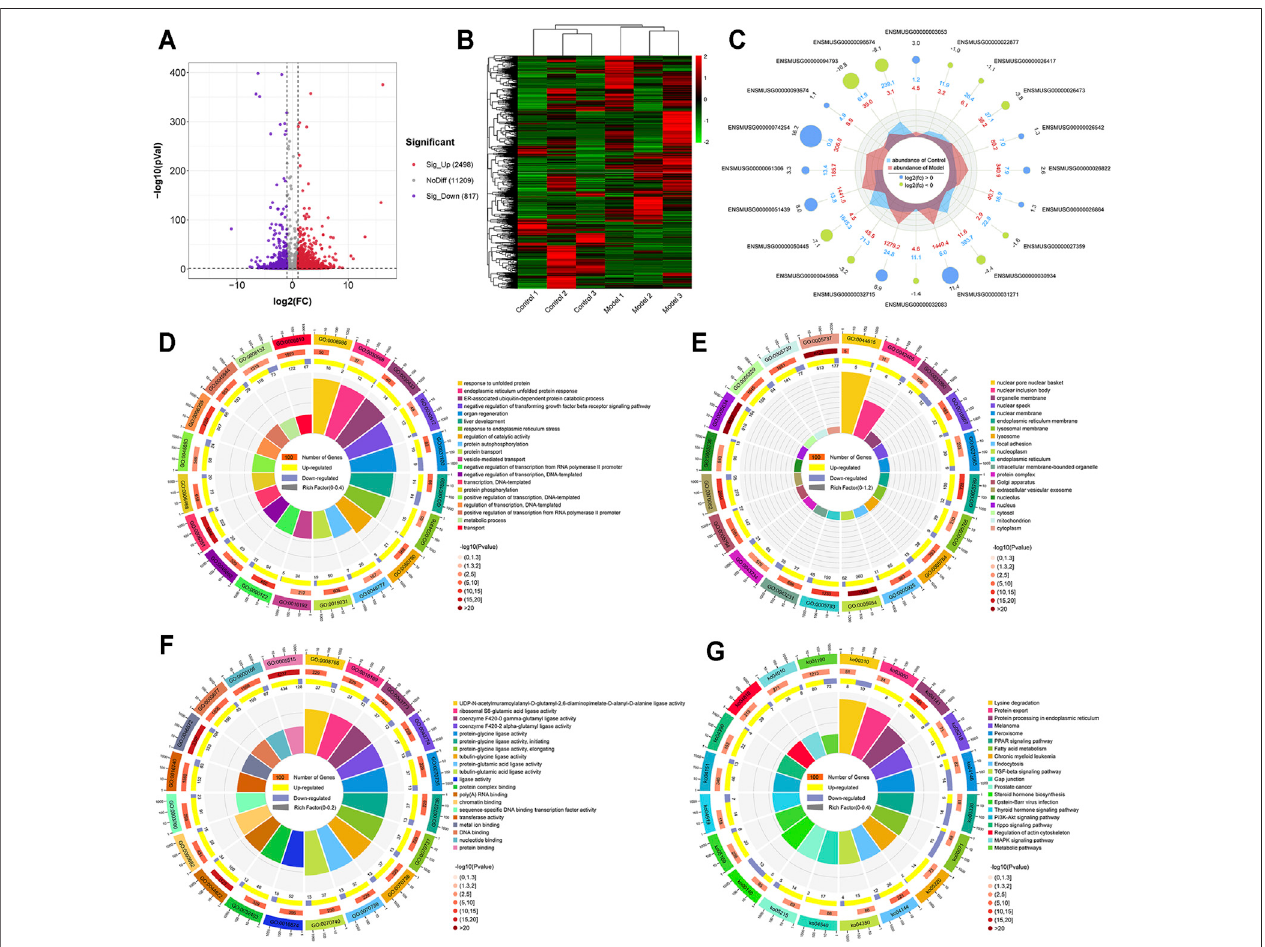
FIGURE 4 | Genes with differential m6A methylation modi fi cation in LF. (A) Volcano plot representation of microarray data on the differentially expressed m6A methylation genes. The blue and red dots tothe left and to the right of the twoverticallines indicate more than a2-fold change and represent the differentially expressed m6Amethylationgeneswithstatisticalsigni fi cance. (B) Hierarchicalclusteranalysisofdifferentiallyexpressedm6Amethylationgenes.Hierarchicalclusteringshowsthat the differentially expressed m6A methylation genes ultimately cluster into two major branches, including hypermethylated genes, which are labeled in red, and hypomethylated genes, which are labeled in green. The darker the color, the more signi fi cant the difference. (C) The radar map shows the top 10 most signi fi cant hypermethylated genes and top 10 hypomethylated genes. (D) GO biological processes enrichment analysis. (E) GO cellular component enrichment analysis. (F) GO molecular function enrichment analysis. (G) KEGG enrichment